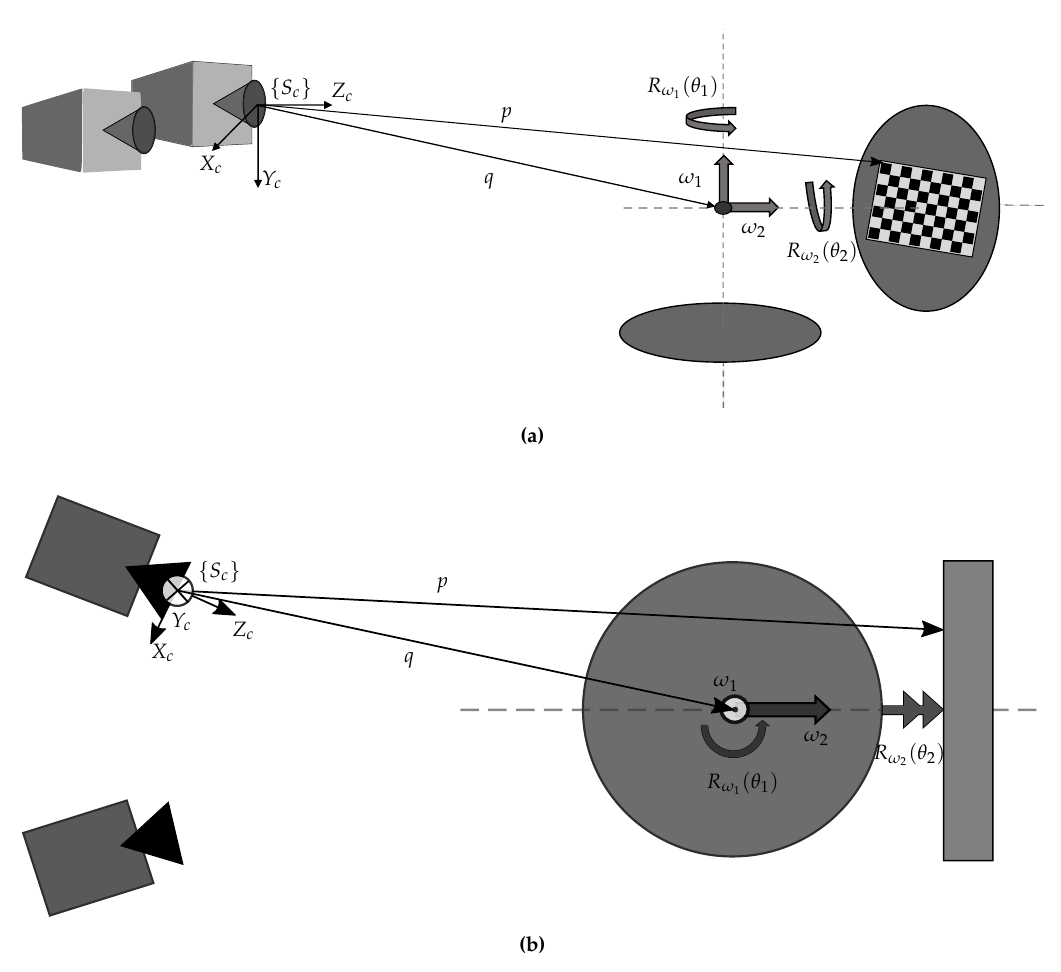
Figure 3. Axes and system representations: ( a ) 3D axonometric view; ( b ) 2D top view. Each axis of the turntable was moved by means of a stepper motor, respectively a NEMA 23 for the vertical axis and a NEMA 17 for the horizontal axis. Both steppers were controlled via Arduino